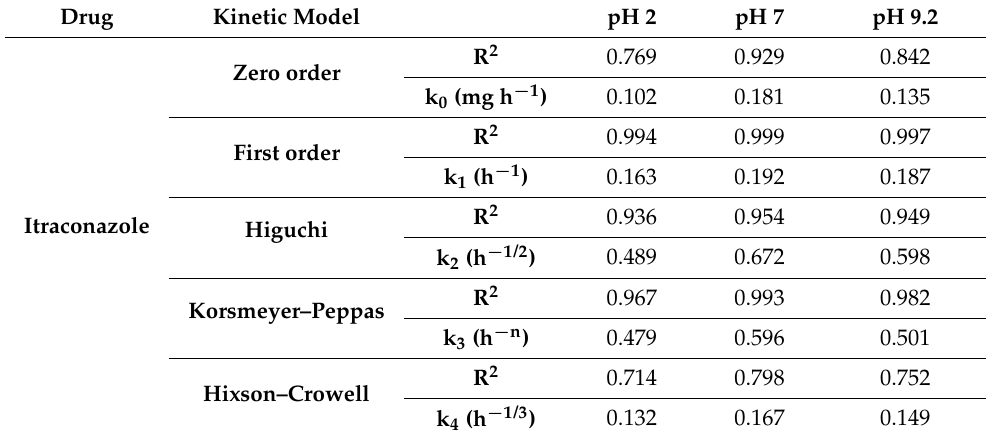
Table 4. Kinetic interpretation of different models for the release of itraconazole from CH-Ag